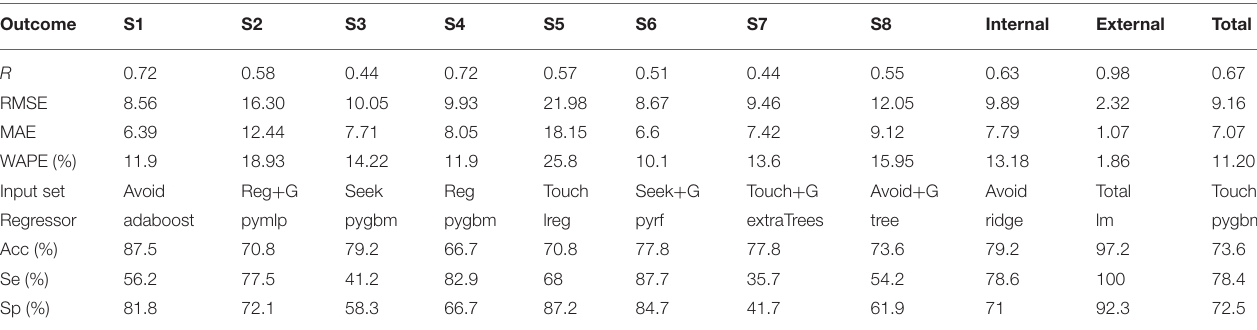
TABLE 3 | Correlation ( R ), RMSE, MAE, WAPE (in %), and input set that achieved the best performance for each CBCL outcome. Outcome S1